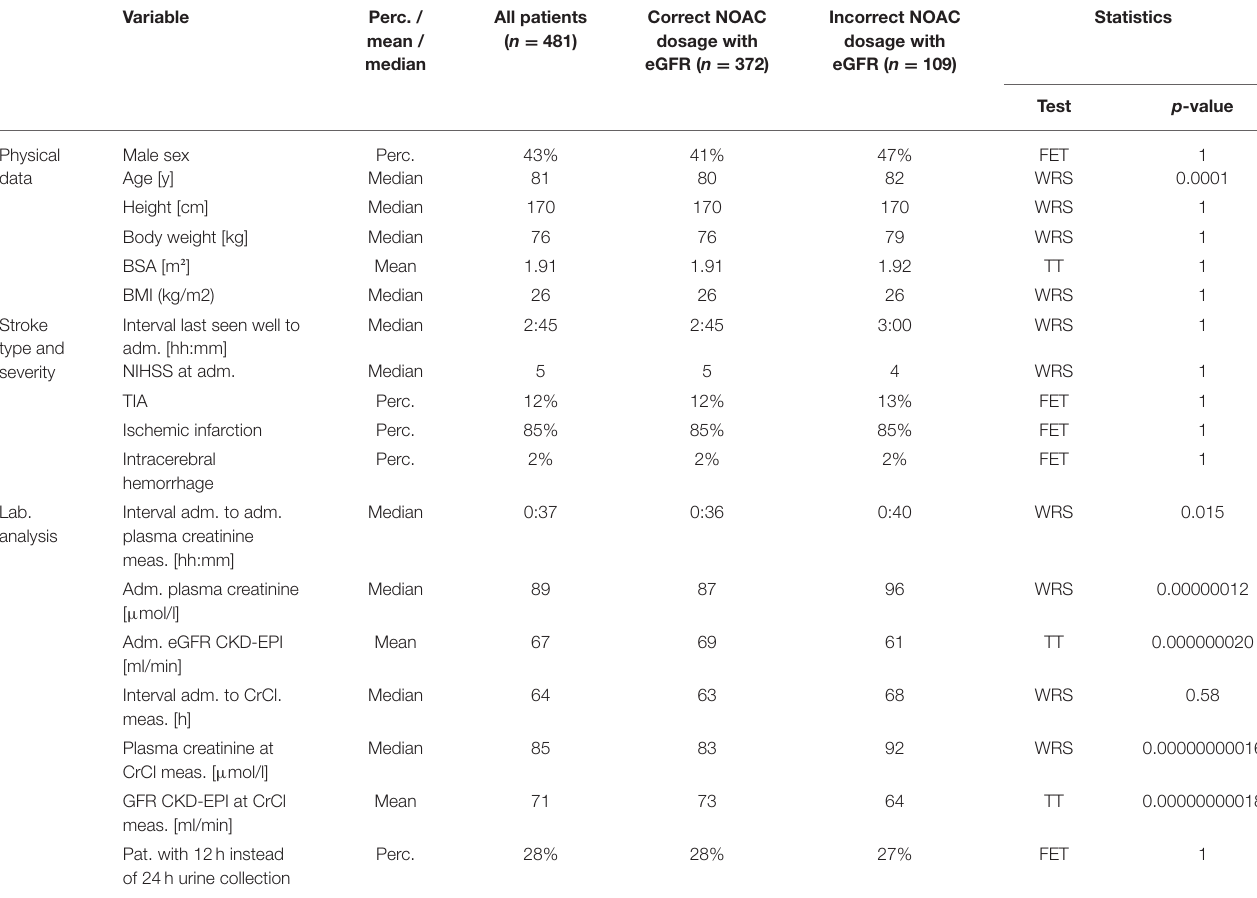
TABLE 3 | Characteristics of study cohort and the subgroup of correct NOAC dosage when relying on eGFR as opposed to the subgroup of incorrect NOAC dosage when relying on eGFR.